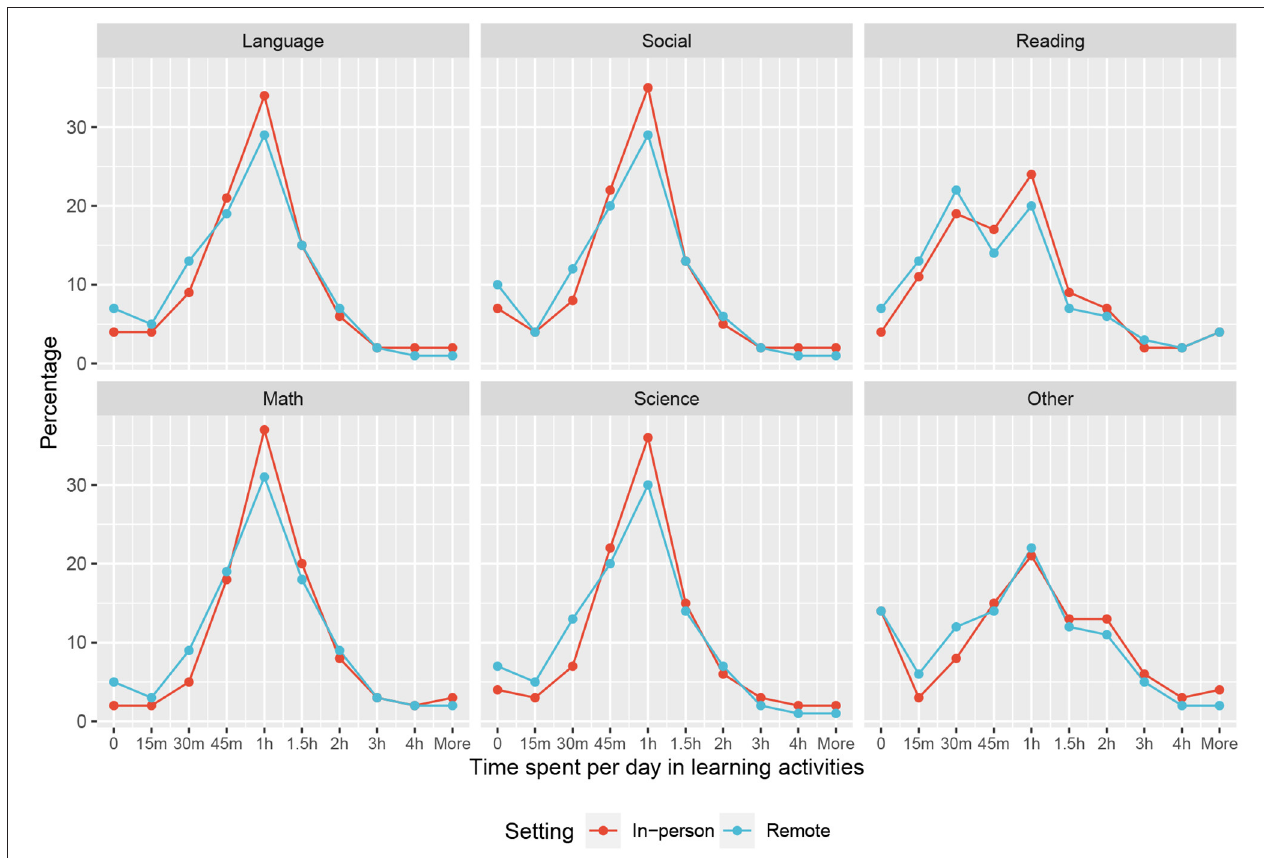
FIGURE 2 | Response distribution (in percent) regarding time spent on several learning activities, as a function of school setting (in-person or remote). teaching concepts, F (2,4469.3) = 12.973, p < 0.001, at